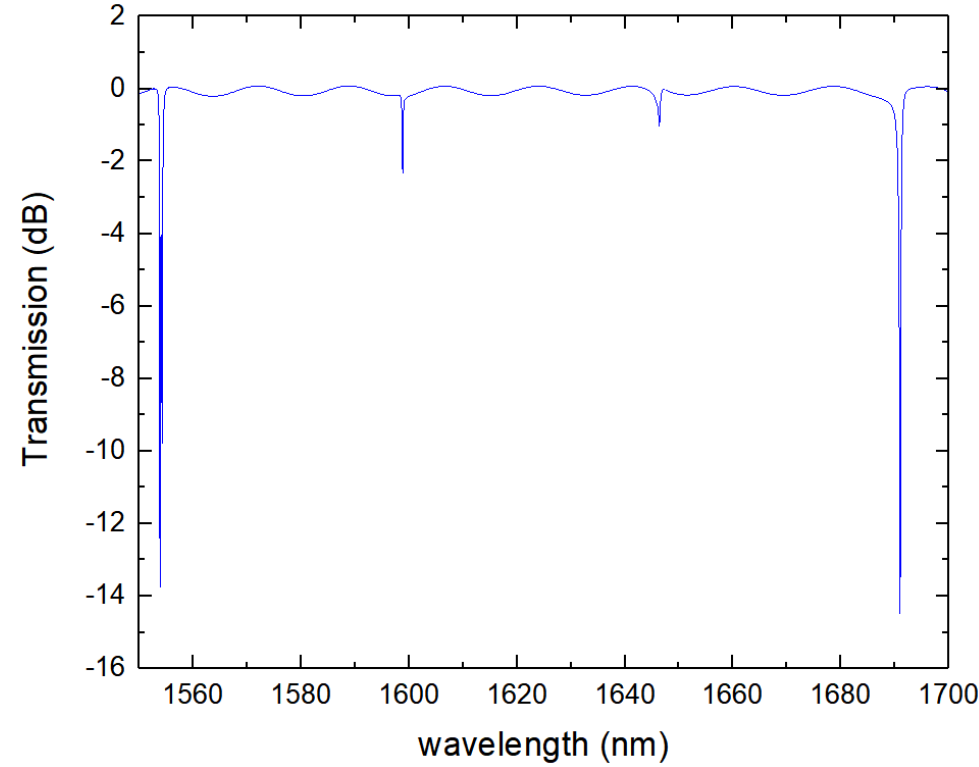
Figure 10. The output spectrum of grating with periods of 70 and 50 on both sides of the slot.